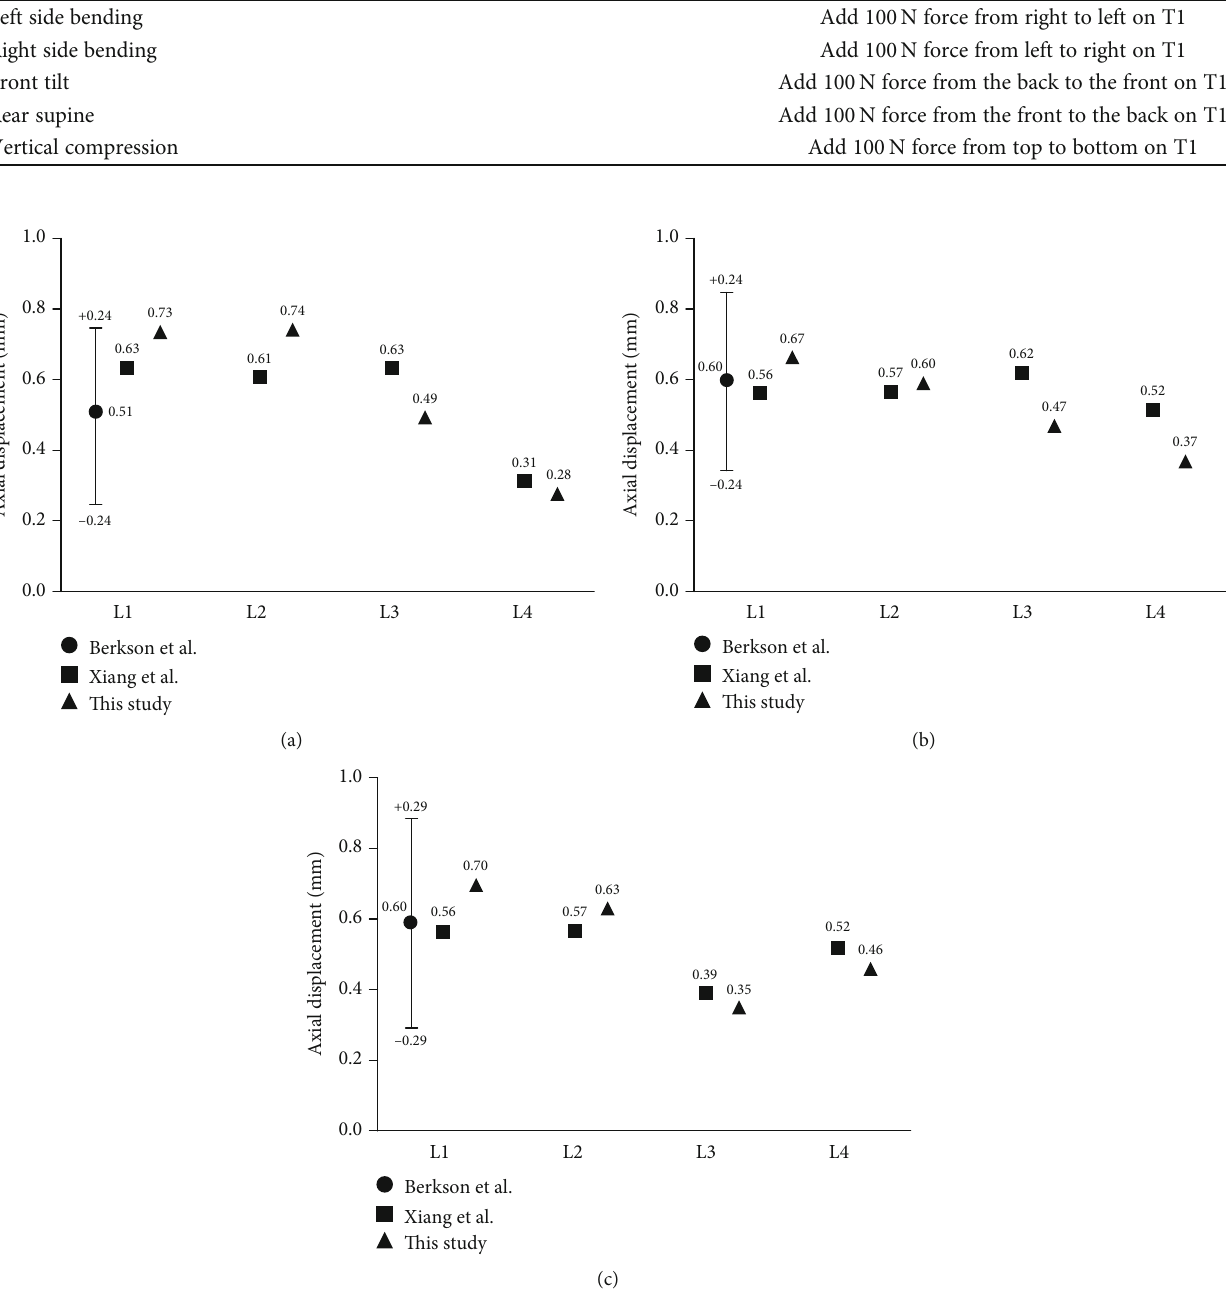
Figure 3: Comparison of FE analysis and experimental results: (a) lumbar vertebral deformation under an axial pressure of 400N; (b) lumbar vertebral deformation under an anterior shear force of 86N; (c) lumbar vertebral deformation under a posterior shear force of 86 N.